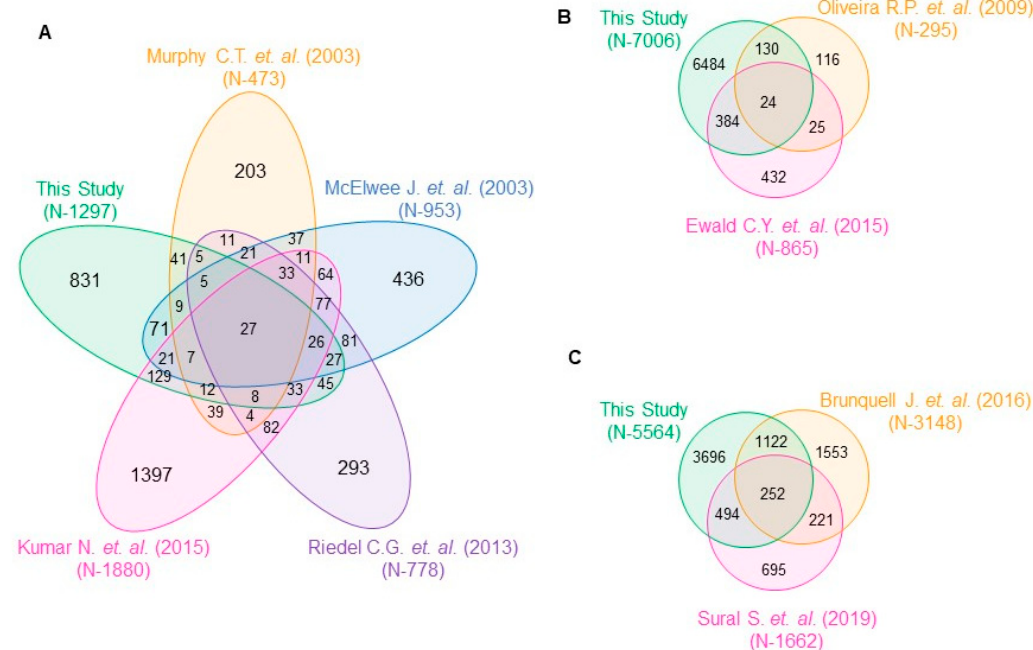
Figure A3. Reduced IIS condition-dependent gene comparison with earlier datasets. Venn diagrams represent the overlap with earlier published datasets. Differentially expressed genes were considered together to compare with earlier